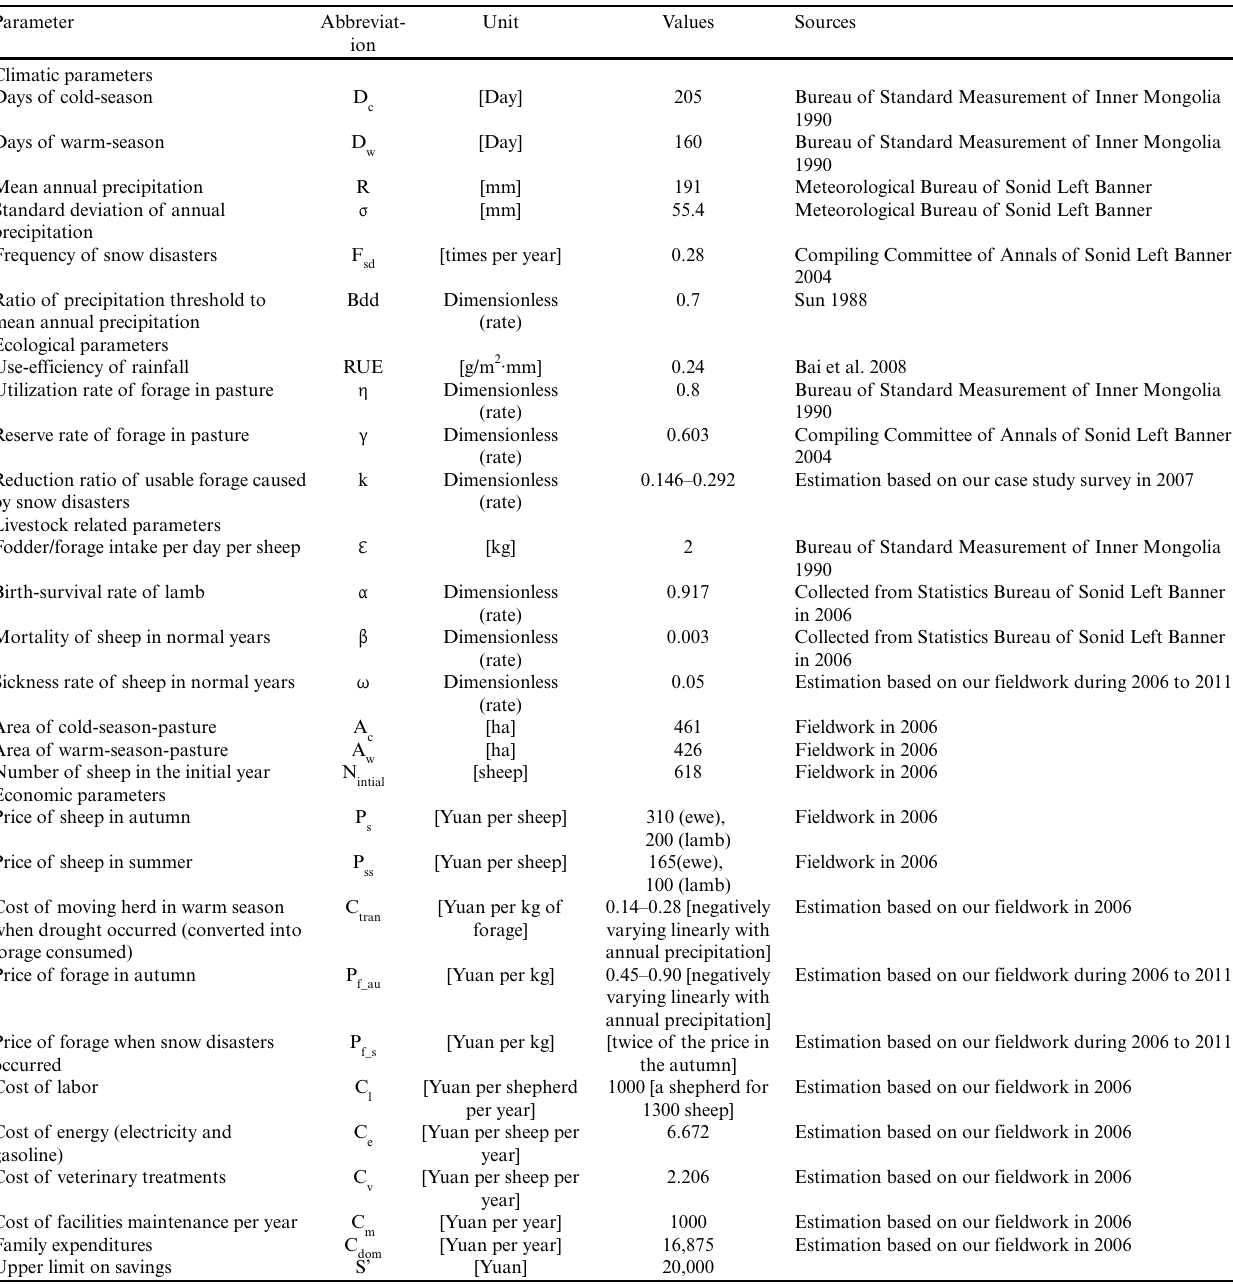
Table 3 . List of parameters, the default parameter set, and